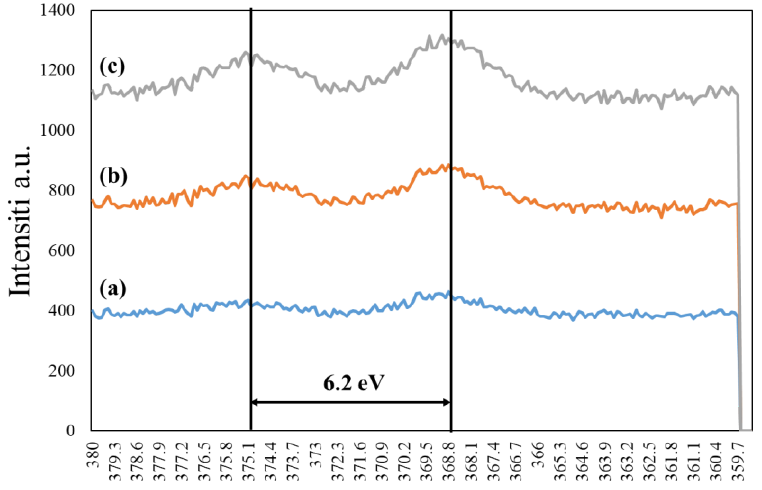
Figure 5. XPS study of PAN/AgNPs nanofibers one cycle loaded: (a), PAN/AgNPs nanofibers two cycles loaded: (b), a PAN/AgNPs nanofibers three cycles loaded: (c).